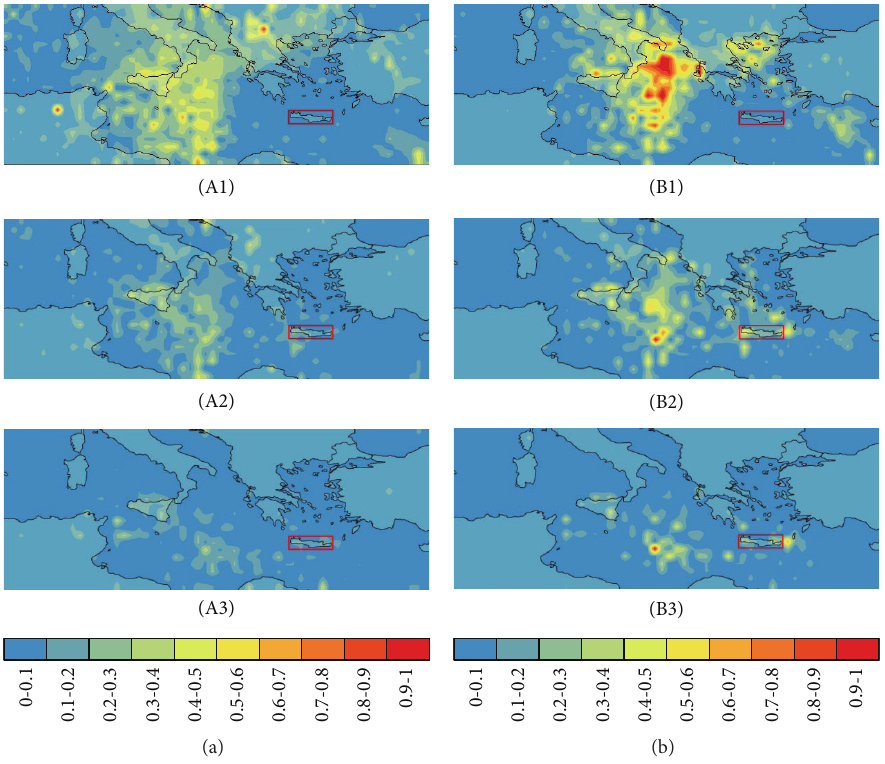
Figure 5: Spatial probability maps (a) and weighted-normalized probability maps (WNP) (b) of “affecting” cyclones for the time period 1979–2011 for (1) light, (2) medium, and (3) heavy rain